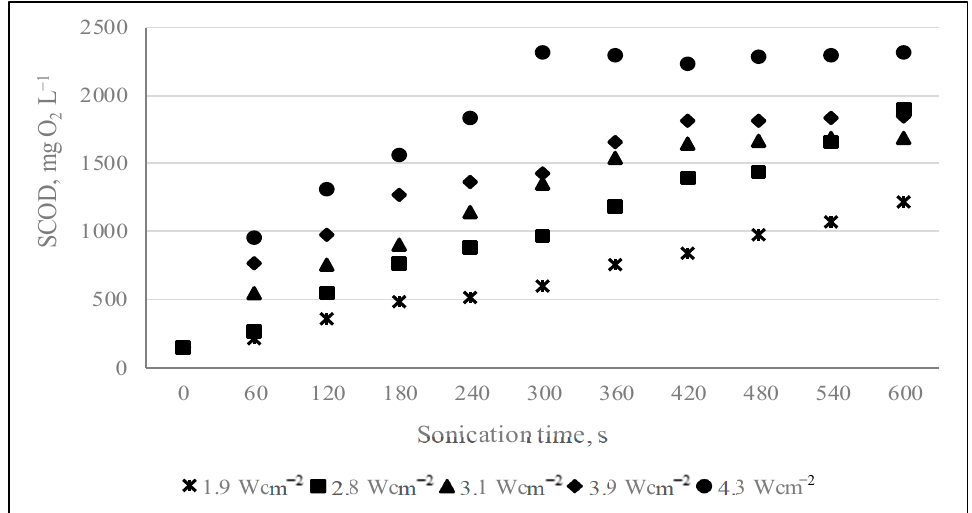
Figure 1. Changes of the SCOD value in the ultrasonic disintegration process for the tested ultrasound field intensity values depending on the sonication time.